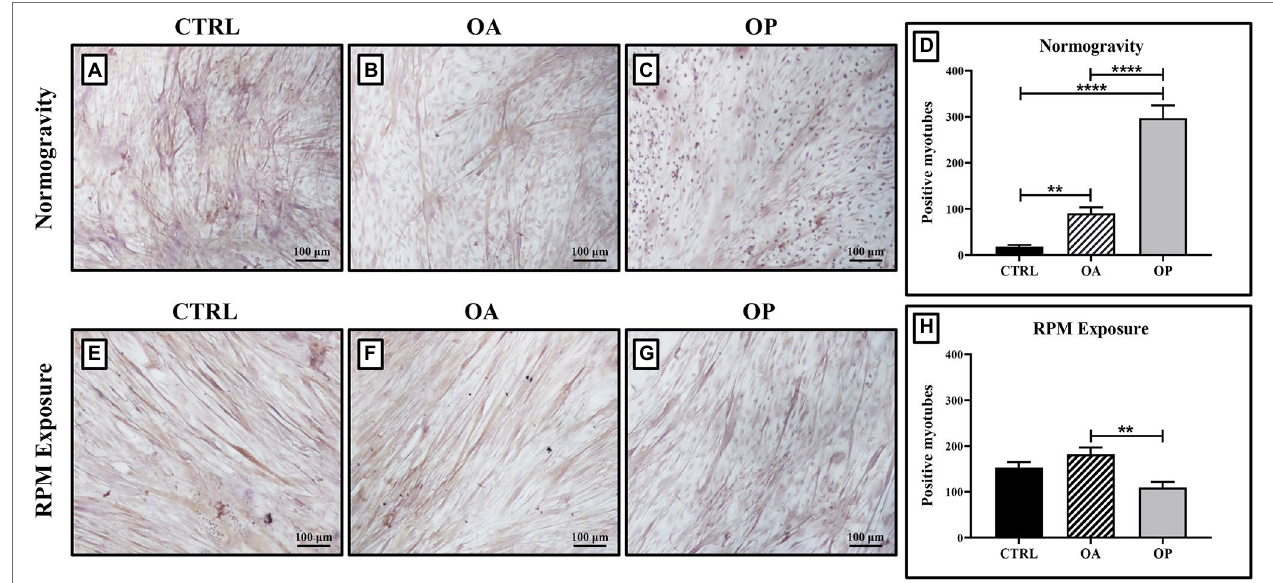
FIGURE 2 | Evaluation of myostatin expression by immunocytochemistry. In cell cultures exposed to normogravity regimen, a significant increase in myostatin expression was observed in OA (B) and OP (C) patients respect to the CTRL group (A) . Note that a significant statistical difference was reported between the following groups (D) : CTRL vs. OA, ** p < 0.01; CTRL vs. OP, **** p < 0.0001; OA vs. OP, **** p < 0.0001. After RPM exposure, primary cultures derived from OP patients (G) showed a significant reduction in myostatin expression, whereas higher levels of myostatin were found in CTRL (E) and OA (F) patients. Note that a significant statistical difference was found only between the OA and OP groups (OA vs. OP, ** p < 0.01; H ). 4x images, scale bar represents 100 μ